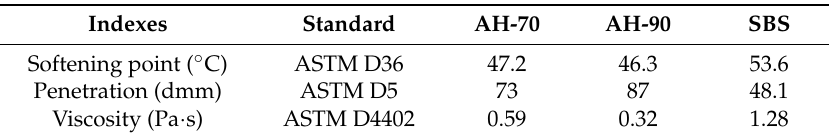
Table 1. Pysical properties of different types of asphalt binders.